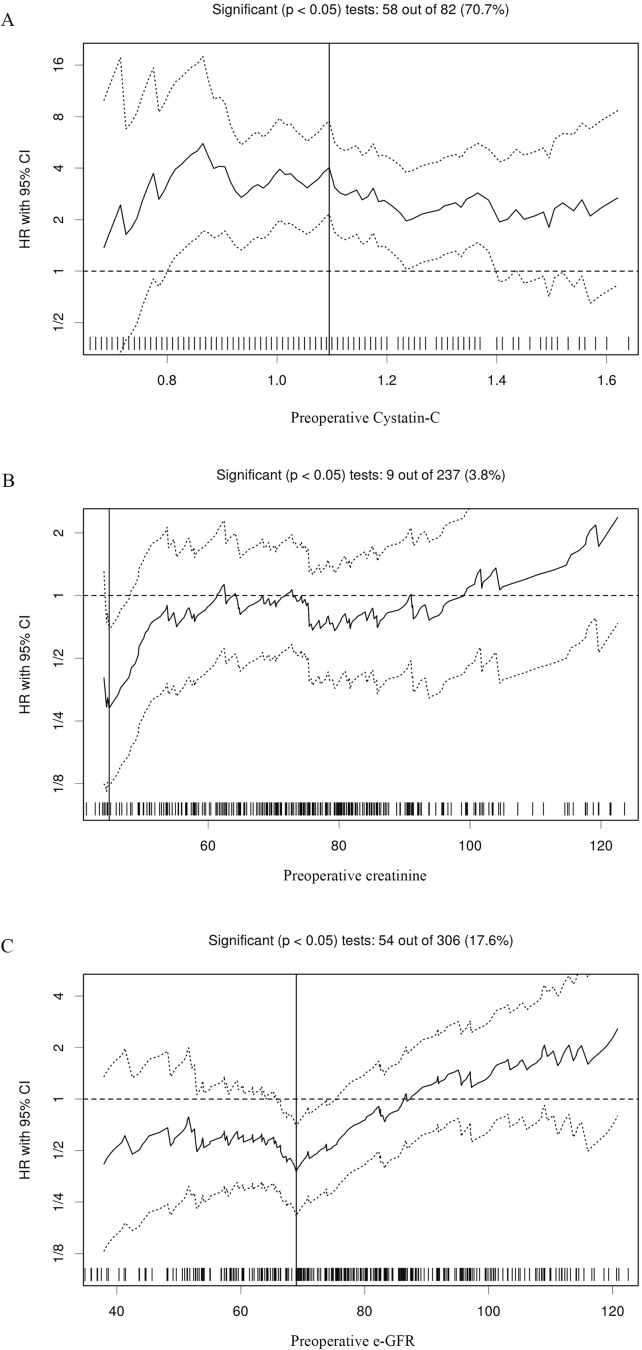
Hazard ratios and cutoff values of independent factors for overall survival of patients with renal cell carcinoma.(A) Preoperative serum cystatin C; (B) Creatinine (CRE); and (C) estimated glomerular filtration rate (e-GFR) (C). The vertical line designates the optimal cutoff values with the most significant (log-rank test) split.